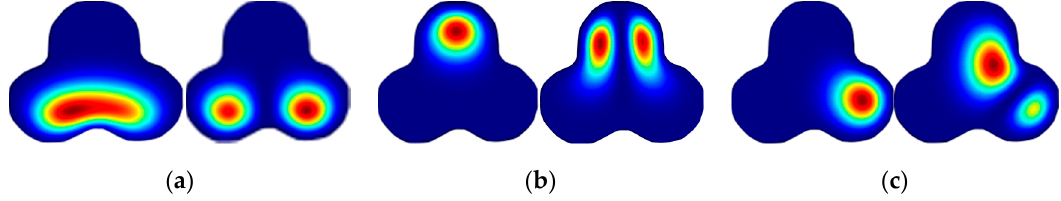
Figure 3. Light field intensity at 645 nm of the two lowest order modes calculated in the imported three-lobe structure cross-section for bending with curvature center placed: ( a ) on the upper surface of the fiber; ( b ) on the lower surface of the fiber; ( c ) on the right-hand surface of the fiber.